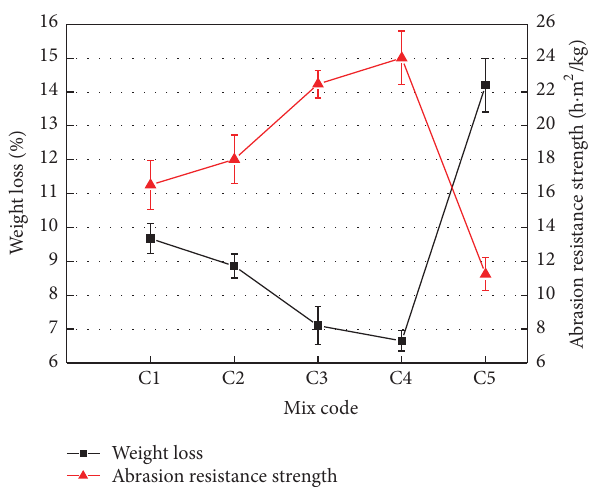
Figure 6: Abrasion resistance test results of the cementitious